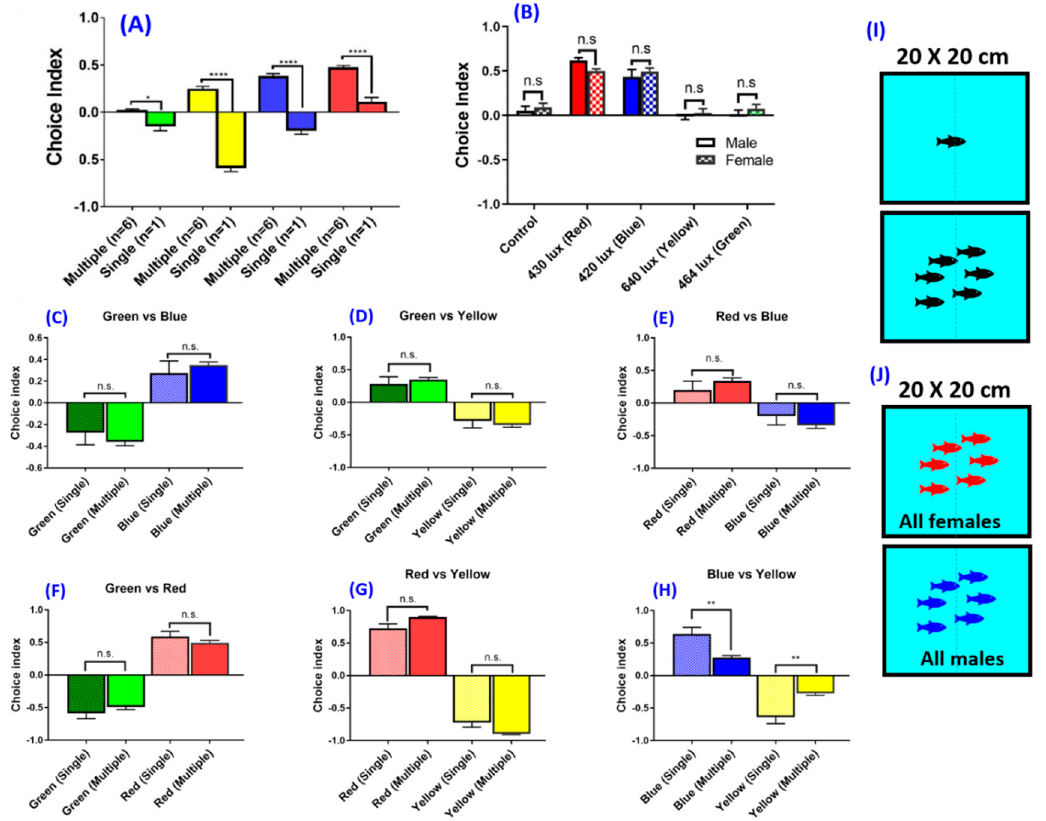
Figure 4. The e ff ect of social interaction and gender on color preference using the top light source. ( A ) The e ff ect of the single fish compared with multiple fish in a single tank on color preference using a blank-color partition. ( B ) The e ff ect of gender on color preference using the light source on top. ( C – H ) The e ff ect of social interaction on color preference using color combinations. ( C ) Green vs. blue combination, ( D ) green vs. yellow combination, ( E ) red vs. blue combination, ( F ) green vs. red combination, ( G ) red vs. yellow combination, ( H ) blue vs. yellow combination. ( I ) Schematics showing two settings in which either single or multiple fish were kept in a single tested tank. ( J ) Schematics showing two settings in which either six male or female fishes were kept in a single tested tank. The data are presented as mean ± SEM, n = 24 for each group. The di ff erence was tested by one-way ANOVA and the significance level was set at * p < 0.05, ** p < 0.01, **** p < 0.0001. n.s. = non- significant.